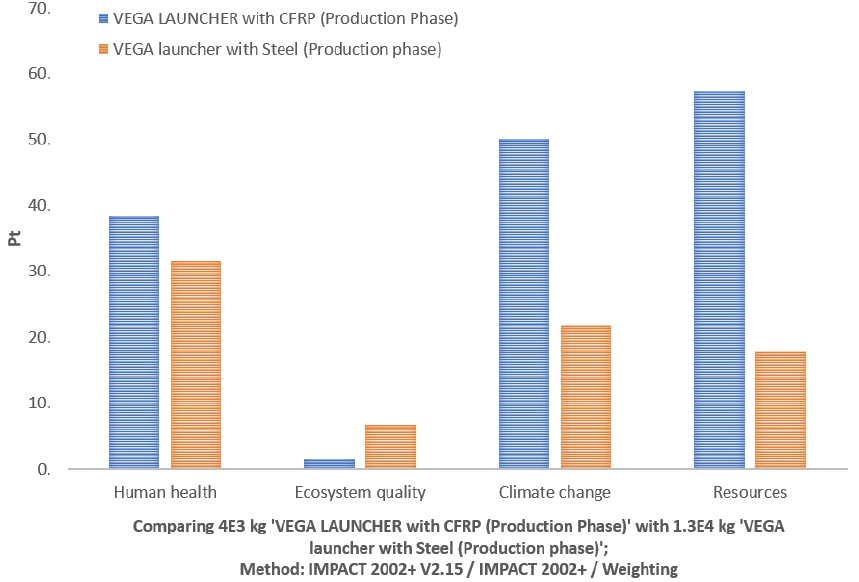
Figure 6. LCA results of comparison of production phase of stainless steel and CFRPs components into endpoint categories.